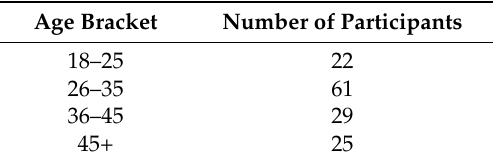
Table 1. The age distribution of